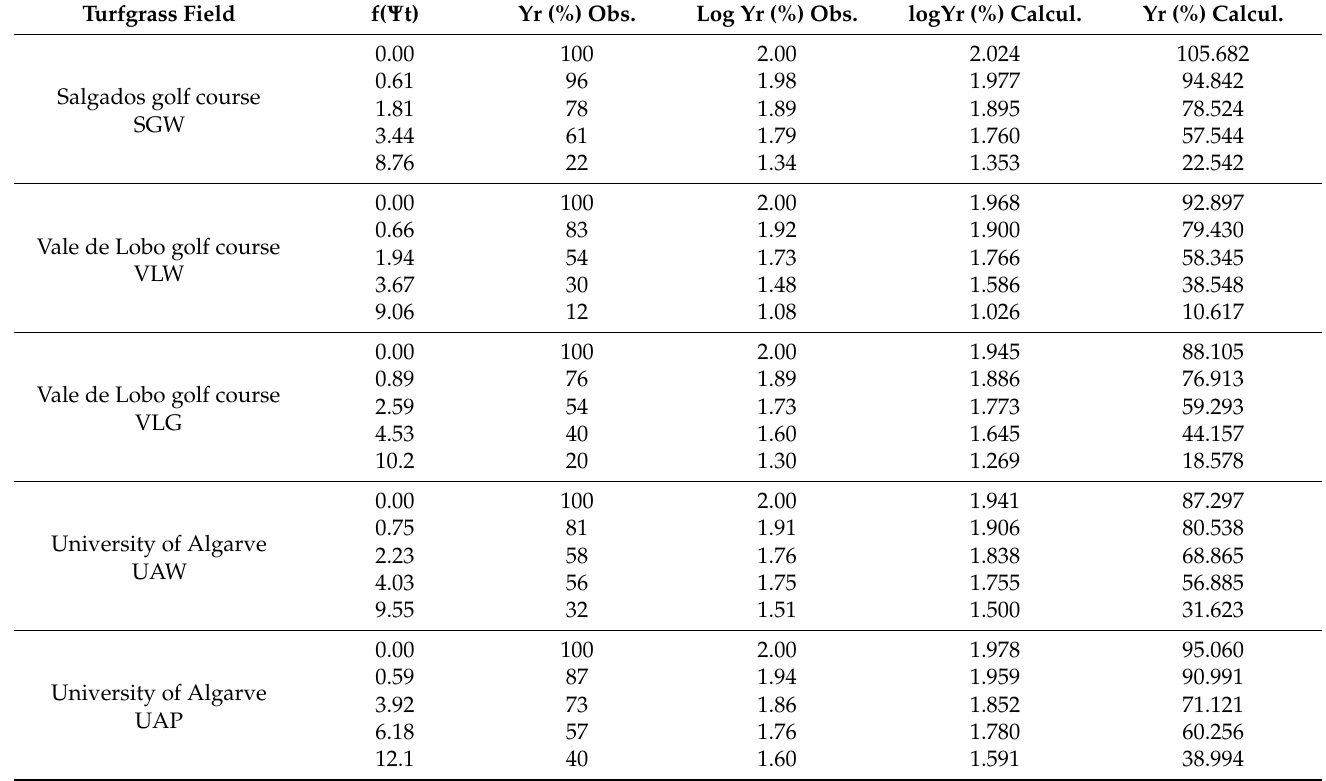
Table 6. Turfgrass relative yield Yr (%) response to the function of the soil total water potential f( Ψ t). Turfgrass Field f( Ψ t) Yr (%) Obs. Log Yr (%) Obs. logYr (%) Calcul. Yr (%) Calcul.